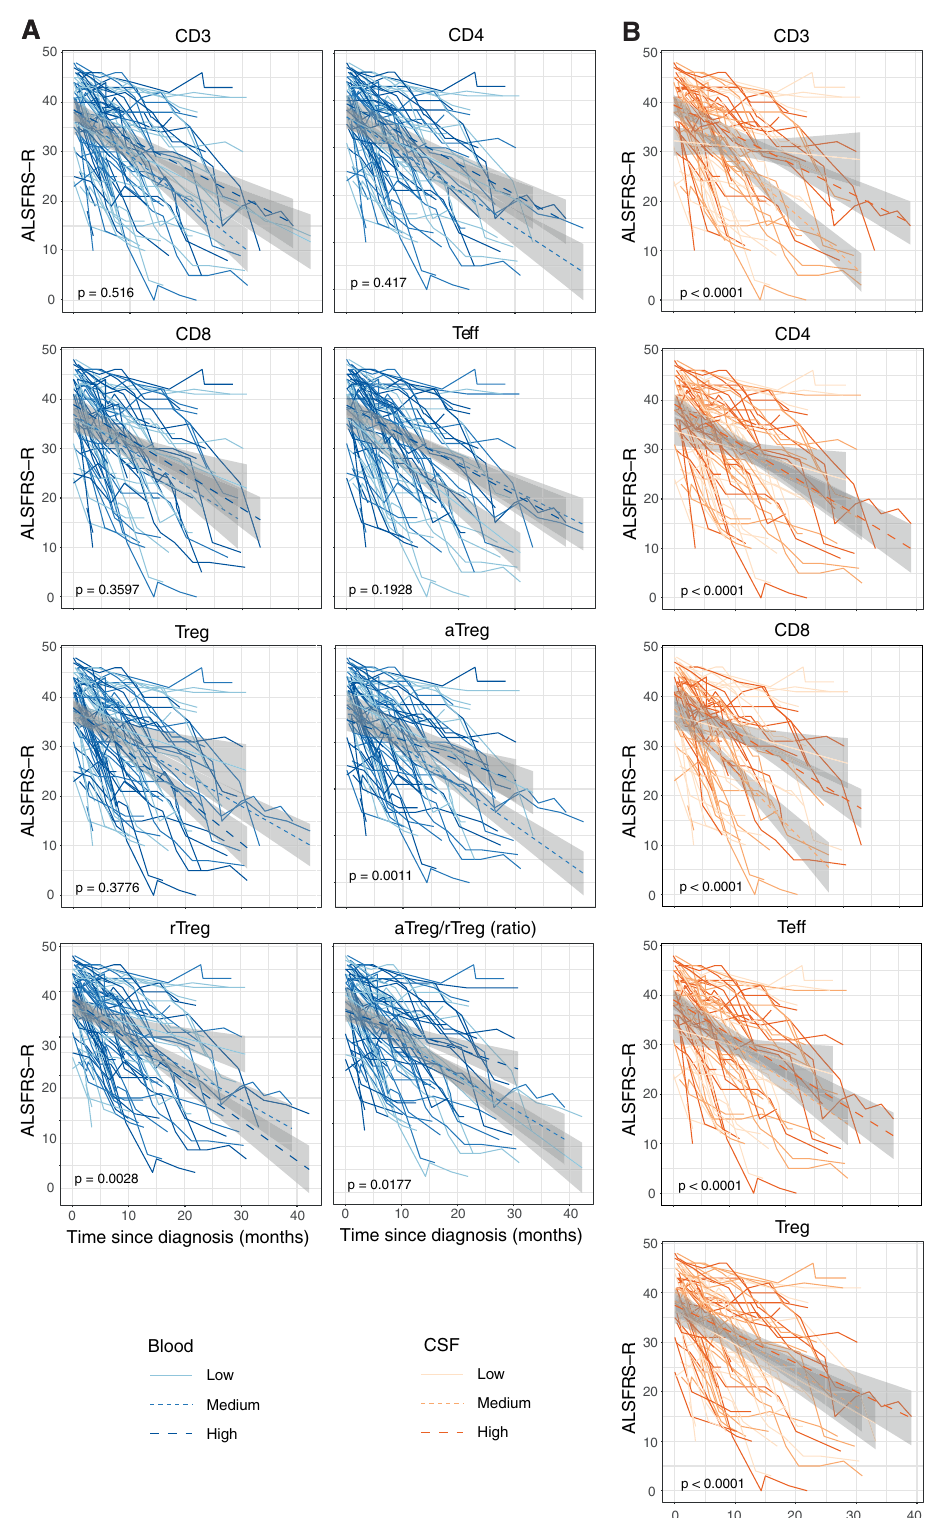
Fig. 1 | Progression rate of newly diagnosed ALS patients. ALS patients were strati fi edbytheproportionofTcellsubsetsintheblood( A )andcerebrospinal fl uid ( B ) at the time of diagnosis. The longitudinal evolution of ALS functional rating